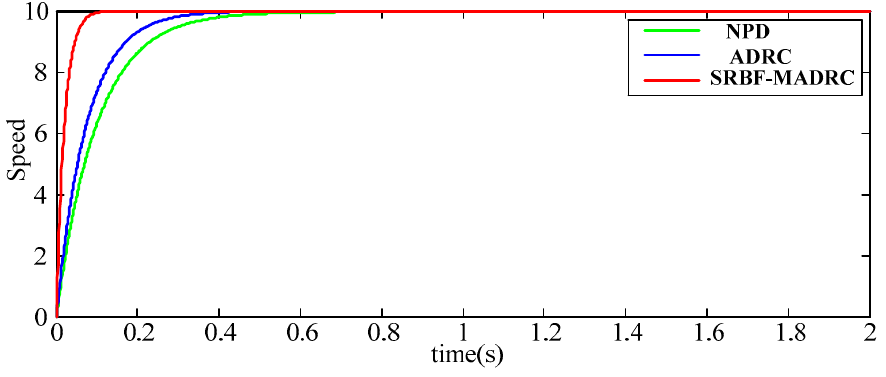
Figure 10. Simulation results of high-speed tracking.